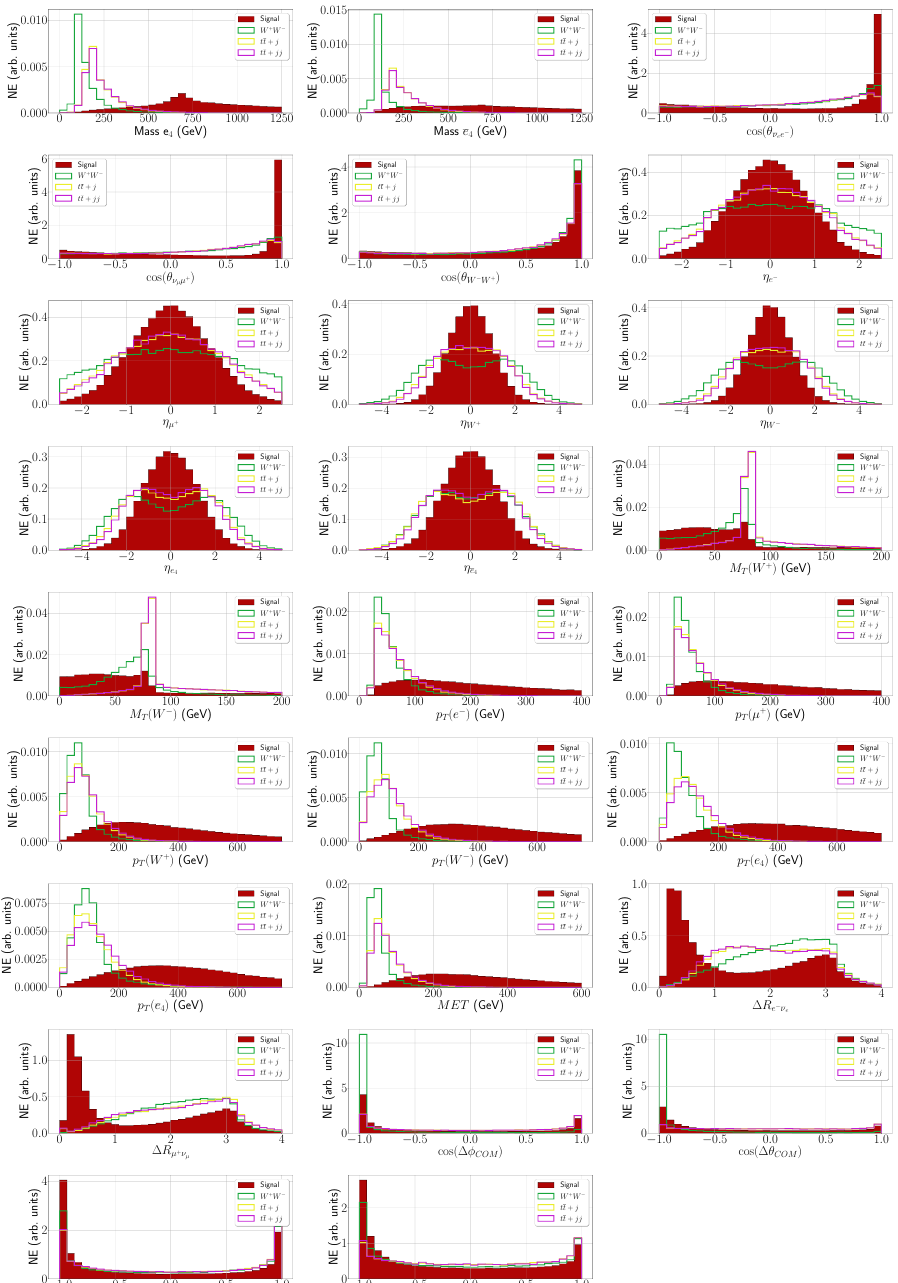
Figure 22. Dimensionless (angular) and dimension-full (kinematic) observables at lab reference frame for VBF channel (solid red), with W + W − (green line), t ¯ t + j (yellow line) and t ¯ t + jj (purple line) backgrounds where it is considered 30 bins for all histograms. From top to bottom left to bottom right, we have distributions for e pseudo-rapidity for e − , µ + , W + , W − , e momentum for e − , µ + , W + , W − , e lab and e ¯ e CM frame. Note that ν is the reconstructed missing energy vector, according to the 4 / 4 discussion in section